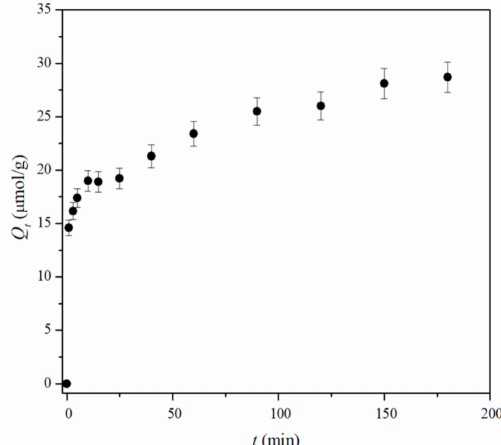
Figure 4. Effect of contact time on V(V) sorption from aqueous solutions onto m-Si-poly(GME)-deta (pH = 5.0, initial ions concentration: 25 mg/dm 3 and T = 298 K).